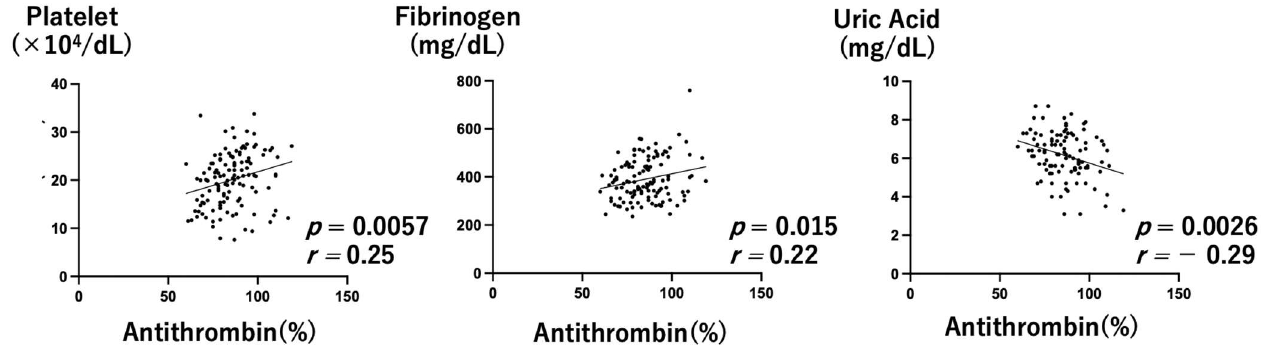
Figure 4. Correlations between antithrombin activity and other factors (platelet, fibrinogen, and uric acid) in the MgSO 4 treatment group.